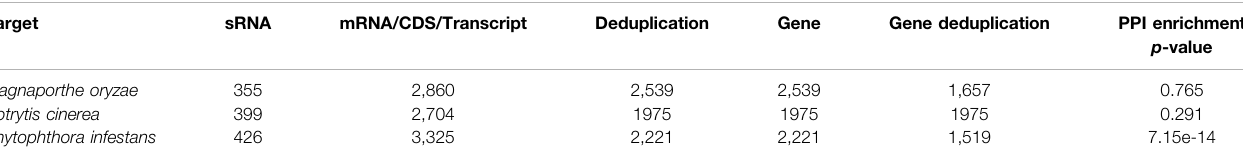
TABLE 4 | Key sRNA targeting